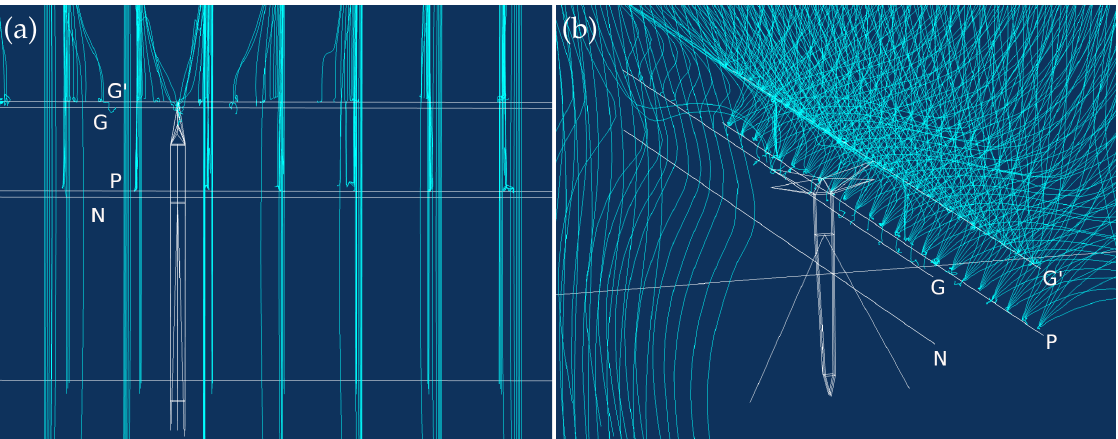
Figure 8. Lightning incidence (cyan lines) for λ = 50 m.